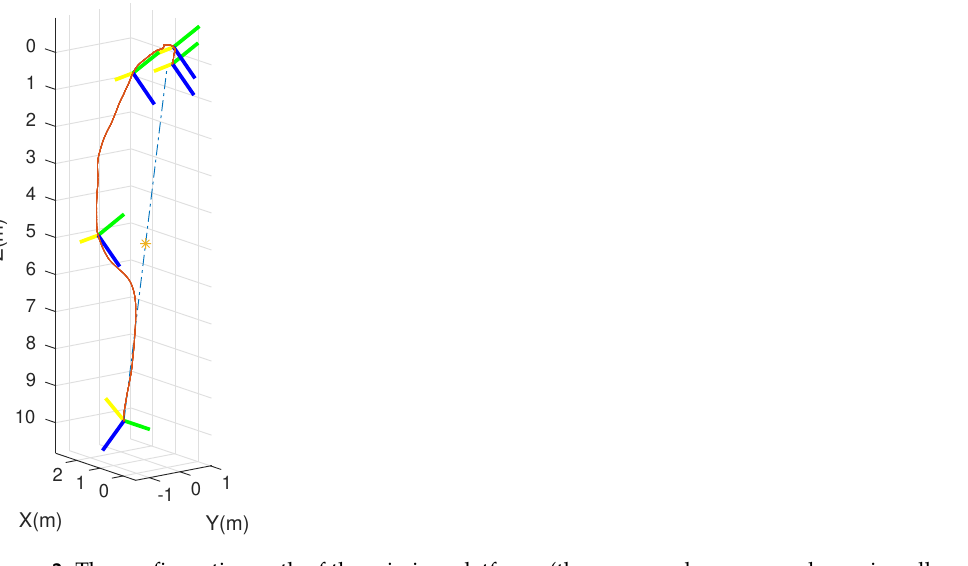
Figure 3. The configuration path of the mission-platform. (the x-, y-, and z-axes are shown in yellow, green, and blue,